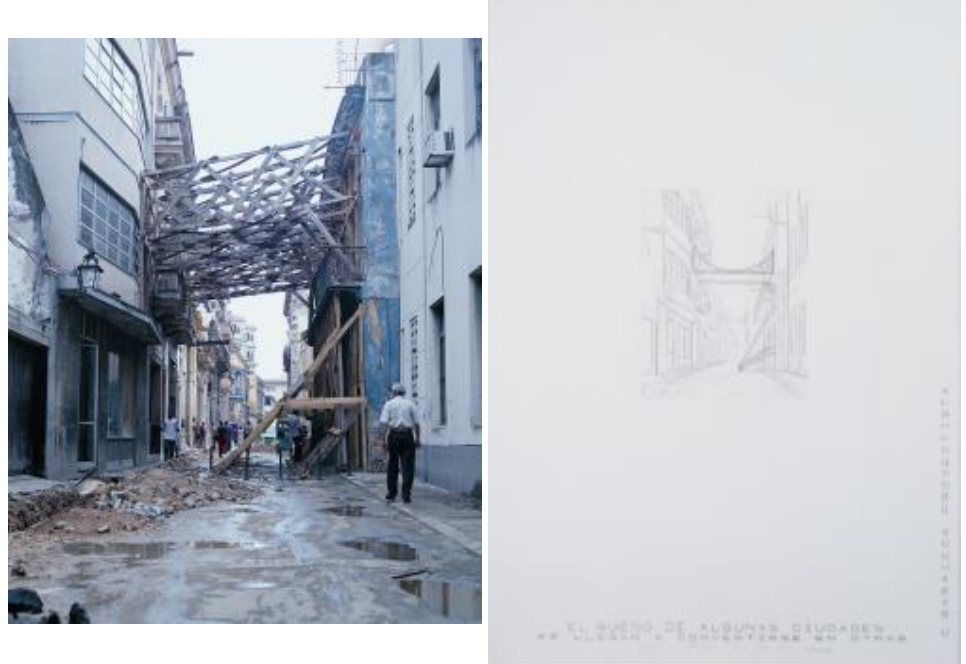
Figure 1 Carlos Garaicoa, El sueño de algunas ciudades es llegar a convertirse en otras (The Dream of Some Cities Is to Become Another), 2001. Left, Duraflex color photograph, 80 x 60 cm. Right, ink and graphite on board, 100 x 70 cm. Copyright Carlos